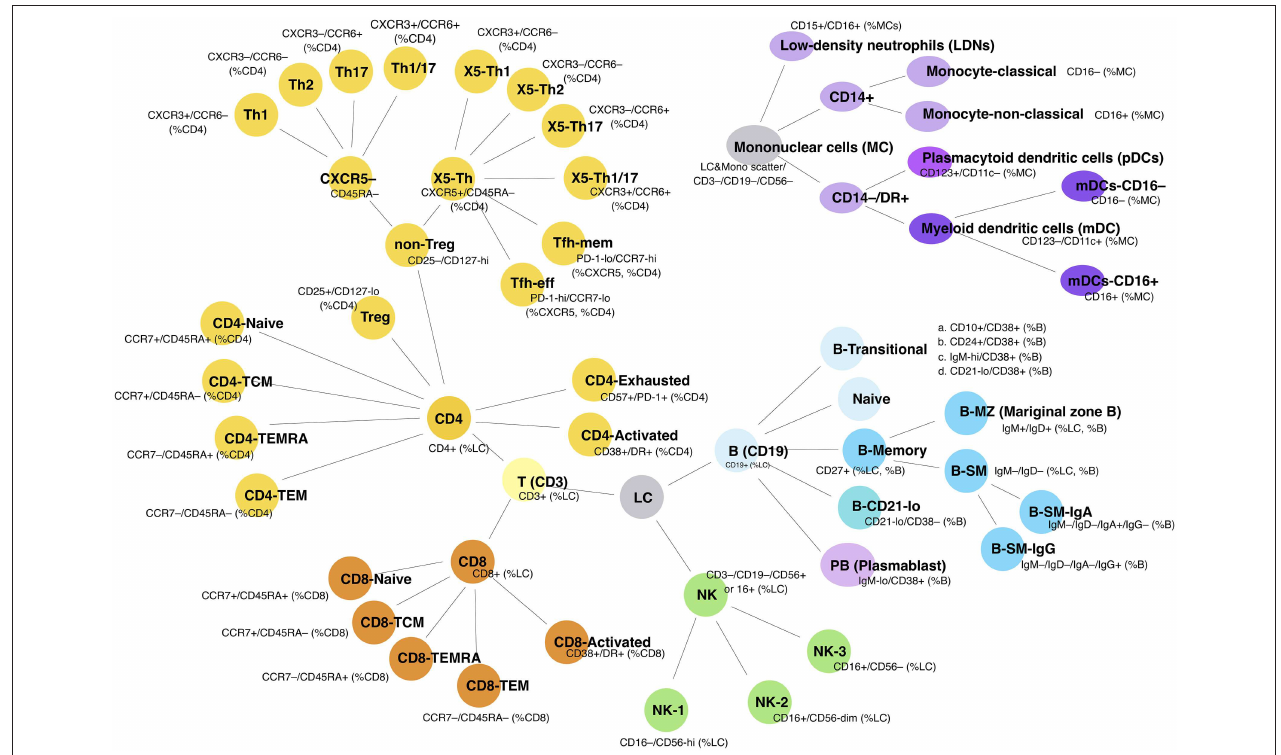
FIGURE 1 | Cellular subpopulations as measured by FCM. Schematic shows the 54 separate cell populations determined using the four antibody panels (see section Methods). Lines show the relationship to parent populations.